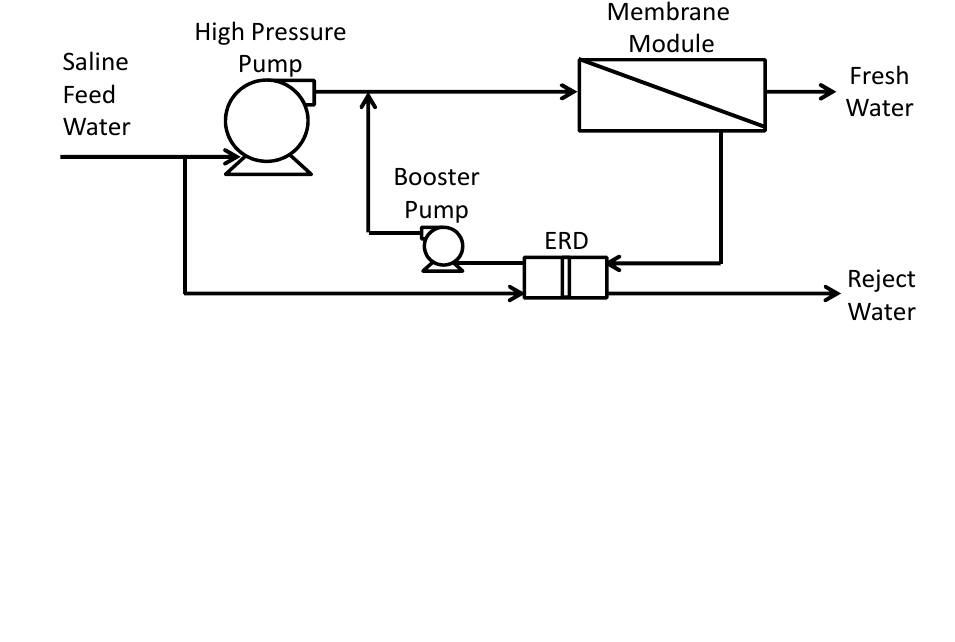
Figure 6. Single-stage system with work exchanger type energy recovery device